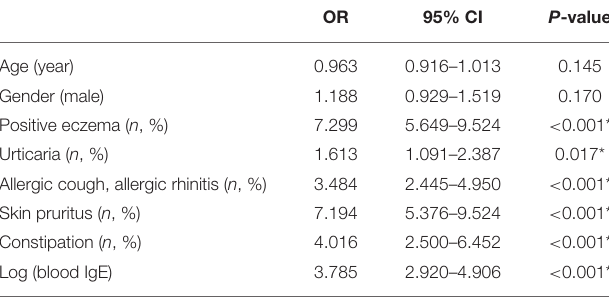
TABLE 2 | Binary logistic regression analysis of OAB risk factors.